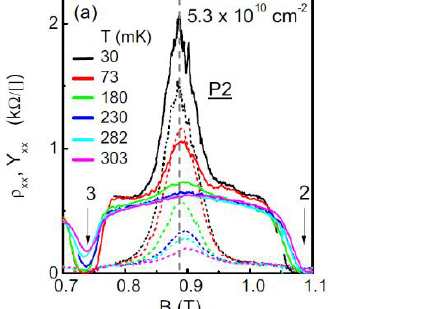
Figure 4. ( a ) Real (solid) and imaginary (dashed) parts of the magnetoresistance for a RIP between υ = 2 and 3 for 2D holes in a 20 nm wide GaAs quantum well. ( b ) Real and imaginary components of the magnetoresistance plotted on a semi-log scale. Figure from Reference [12].